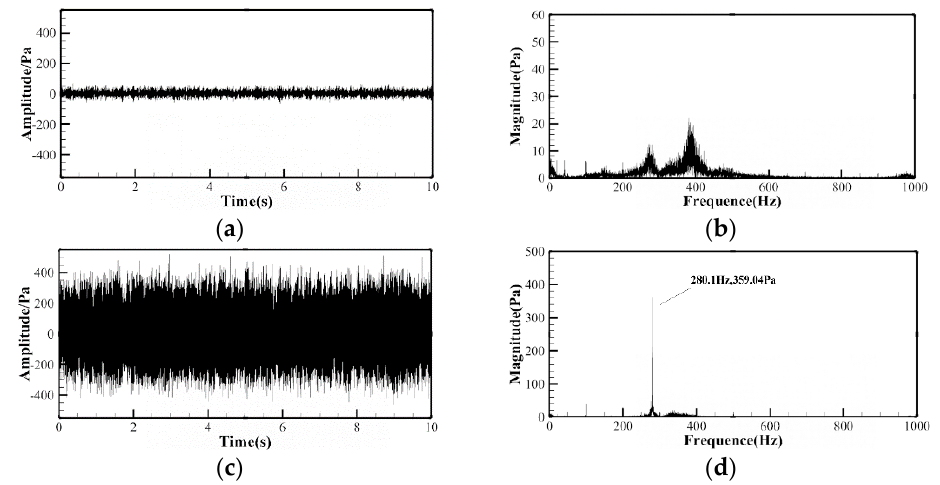
Figure 6. DP time-series signal and frequency spectra of steady and unstable combustion. ( a , b ) Stable combustion state, equivalence ratio is 0.285; ( c , d ) Unstable combustion state, equivalent ratio is 0.228.